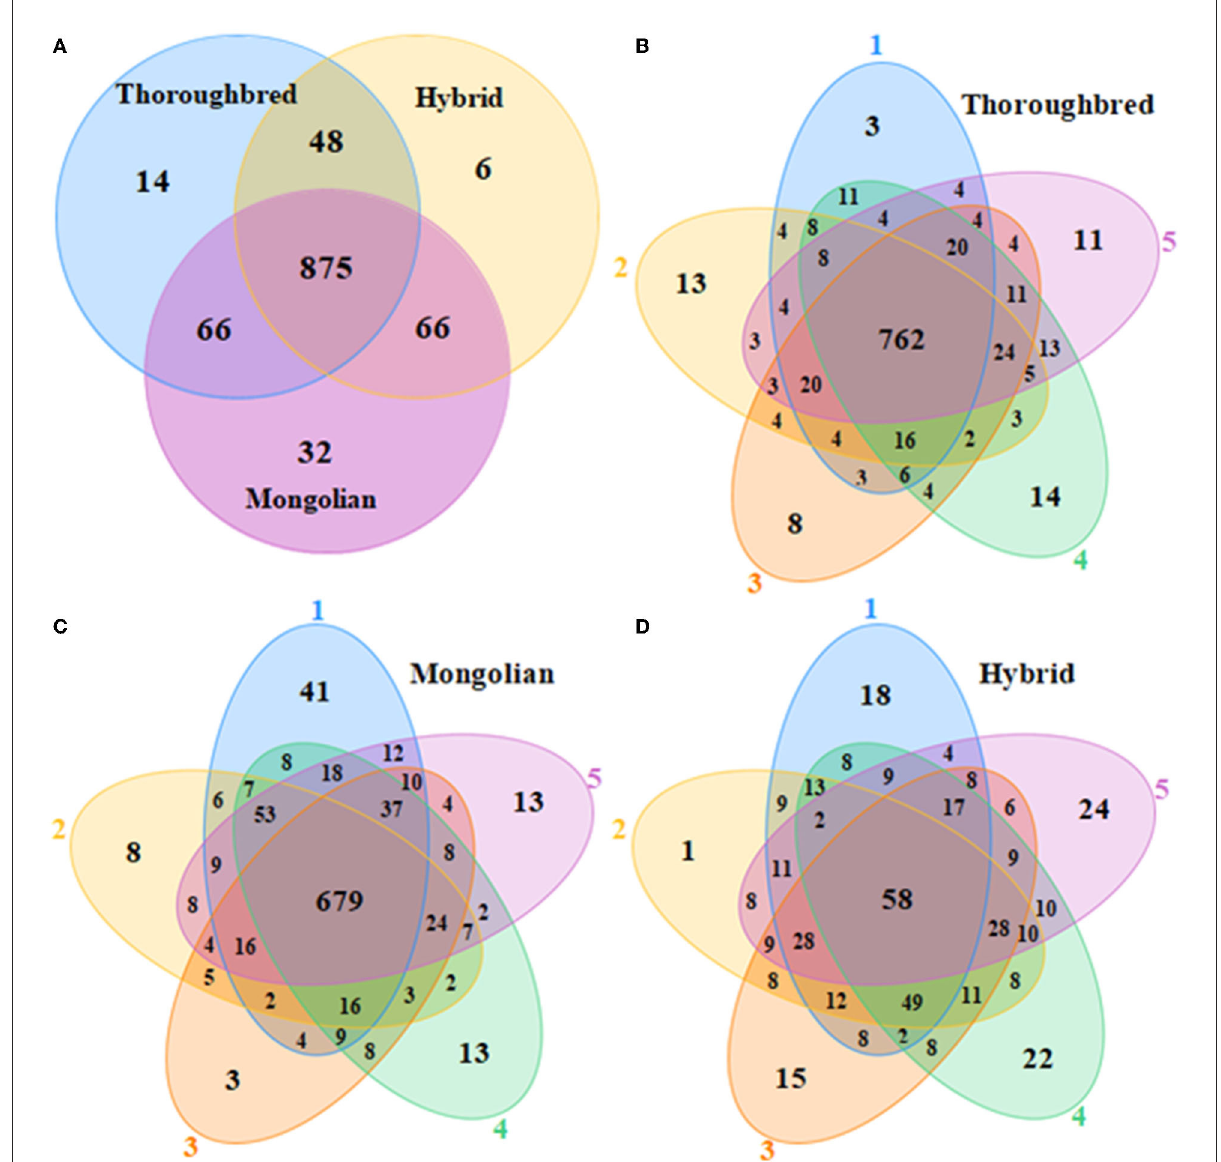
FIGURE1 Venn diagrams. (A) Venn diagram of OTU distributions between Thoroughbred, Mongolian, and Hybrid horses. (B–D) Flower diagrams of OTU distribution between samples in Thoroughbred, Mongolian, and Hybrid horses, respectively.